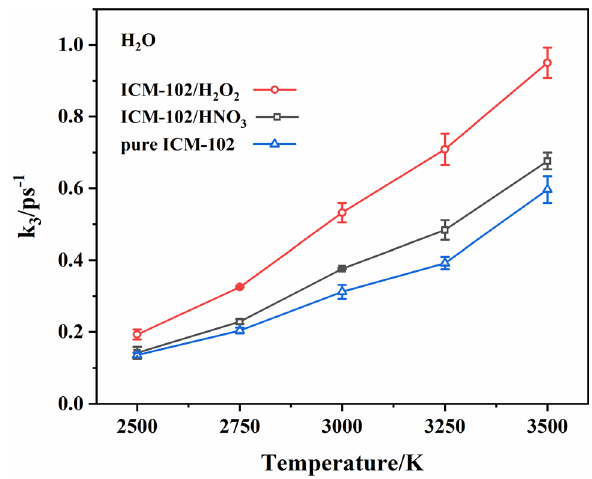
Figure 12. Comparison of the H 2 O formation rates in the pure ICM-102, ICM-102/H 2 O 2 and ICM-102/HNO 3 systems at different temperatures.